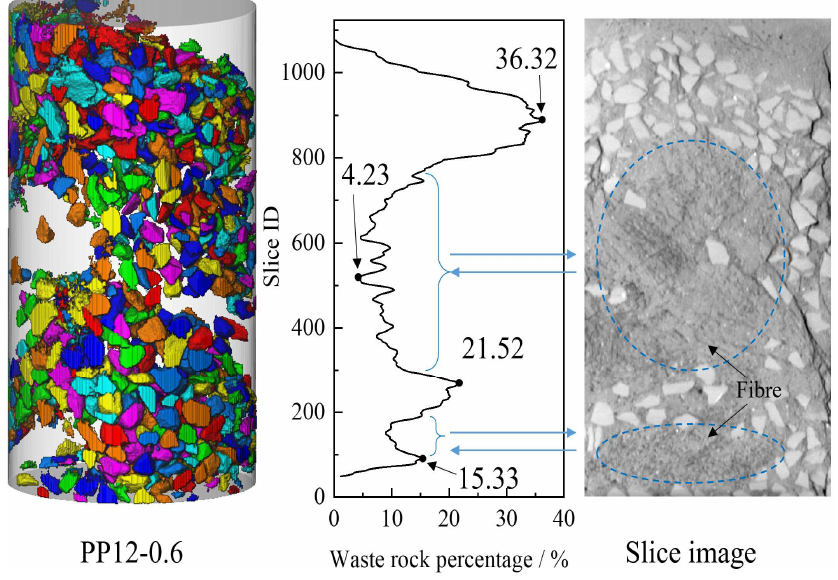
Figure 8. Distribution pattern of waste rock within PP12-0.6.